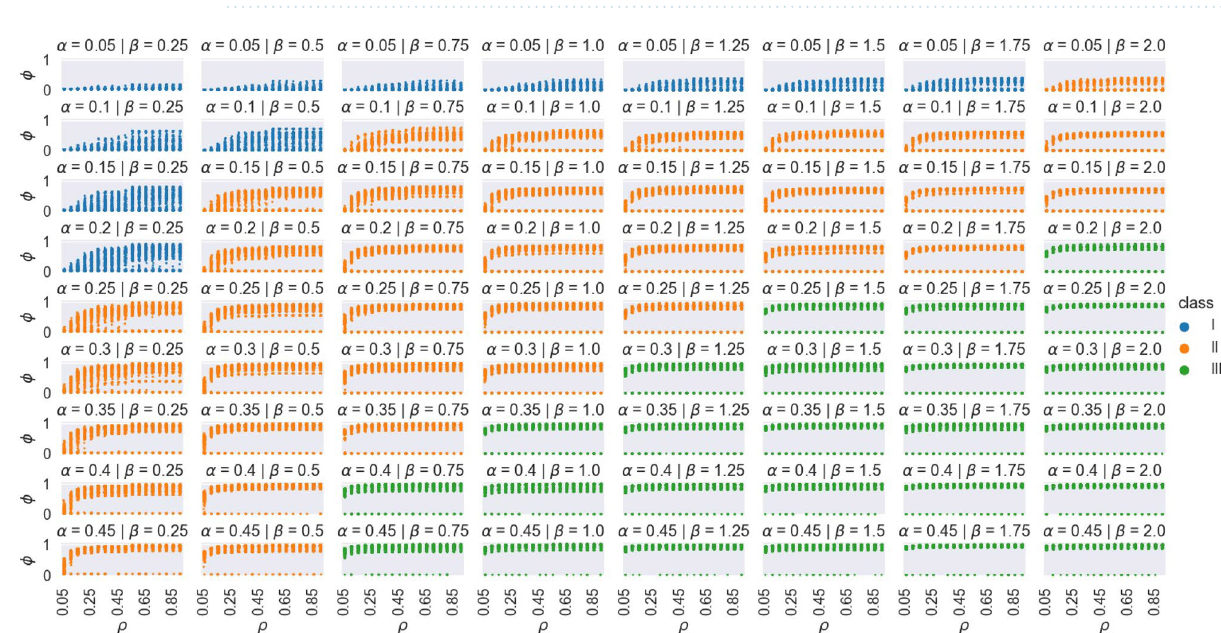
Figure 7. Density plot of φ by maximal network centrality, C max , under varying α and β .